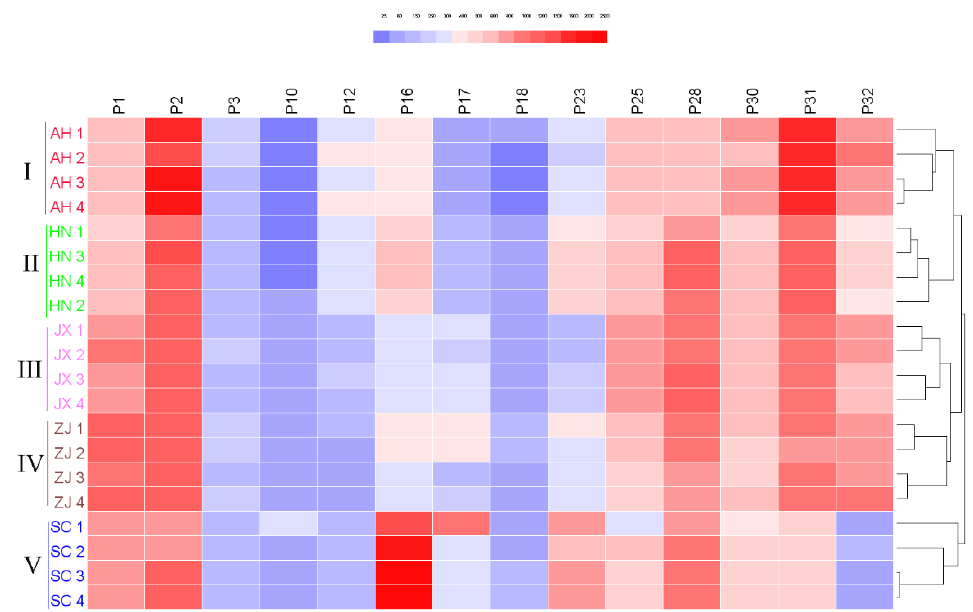
Figure 7. The PCA: principal component analysis ( A ) and OPLS-DA: orthogonal partial least-squares discriminant analysis ( B ) scores plot of 20 batches of Chansu samples based on peak area data of fourteen characteristic compounds.